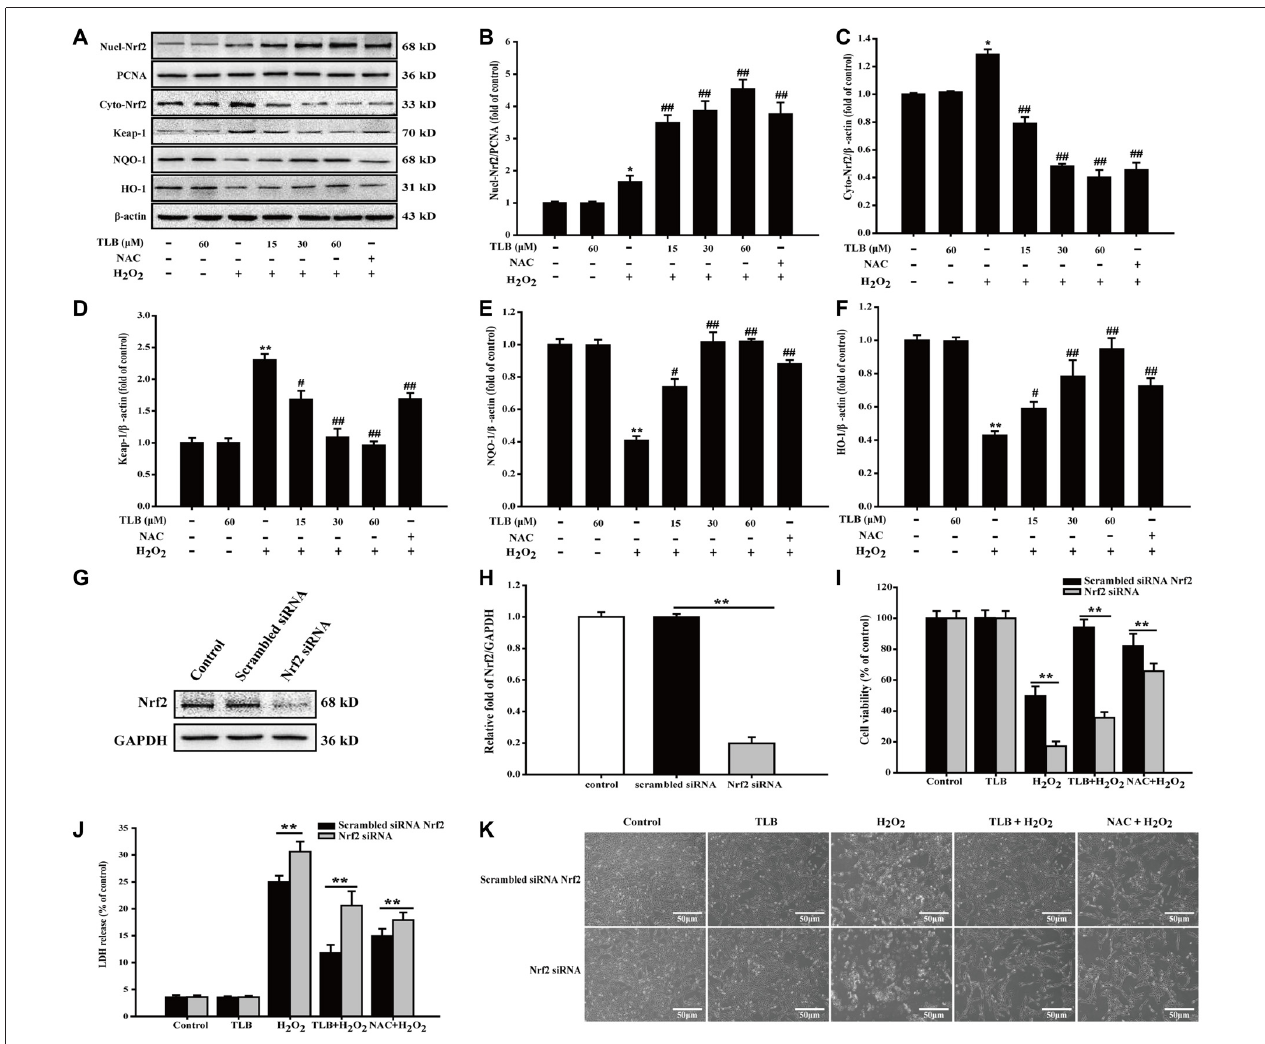
FIGURE 6 | The role of nuclear factor erythroid 2-related factor 2 (Nrf2) signaling pathway in the protective effect of TLB on H 2 O 2 -induced PC12 cells injury. (A) Representative Western blot were shown for Nrf2, Keap-1, NQO-1 and HO-1 proteins. (B) Quantitation of nuclear Nrf2 protein. (C) Quantitation of cytoplasmic Nrf2 protein. (D) Quantitation of Keap-1 protein. (E) Quantitation of NQO-1 protein. (F) Quantitation of HO-1 protein. Nrf2 knockdown markedly abolished the cytoprotective effects of TLB in PC12 cells. (G) Representative Western blot was shown for Nrf2 siRNA. (H) Quantitation of Nrf2 siRNA protein. (I) Cell viability was determined in PC12 cells transfected with or without Nrf2 siRNA. (J) LDH release was determined in PC12 cells transfected with or without Nrf2 siRNA. (K) Morphological changes was observed in PC12 cells transfected with or without Nrf2 siRNA. Magnification, 200 × ; scale bar = 50 µ m. Data were presented as mean ± SD of three independent experiments. ∗ P < 0.05, ∗∗ P < 0.01 vs. untreated control cells; # P < 0.05, ## P < 0.01 vs. H 2 O 2 -treated